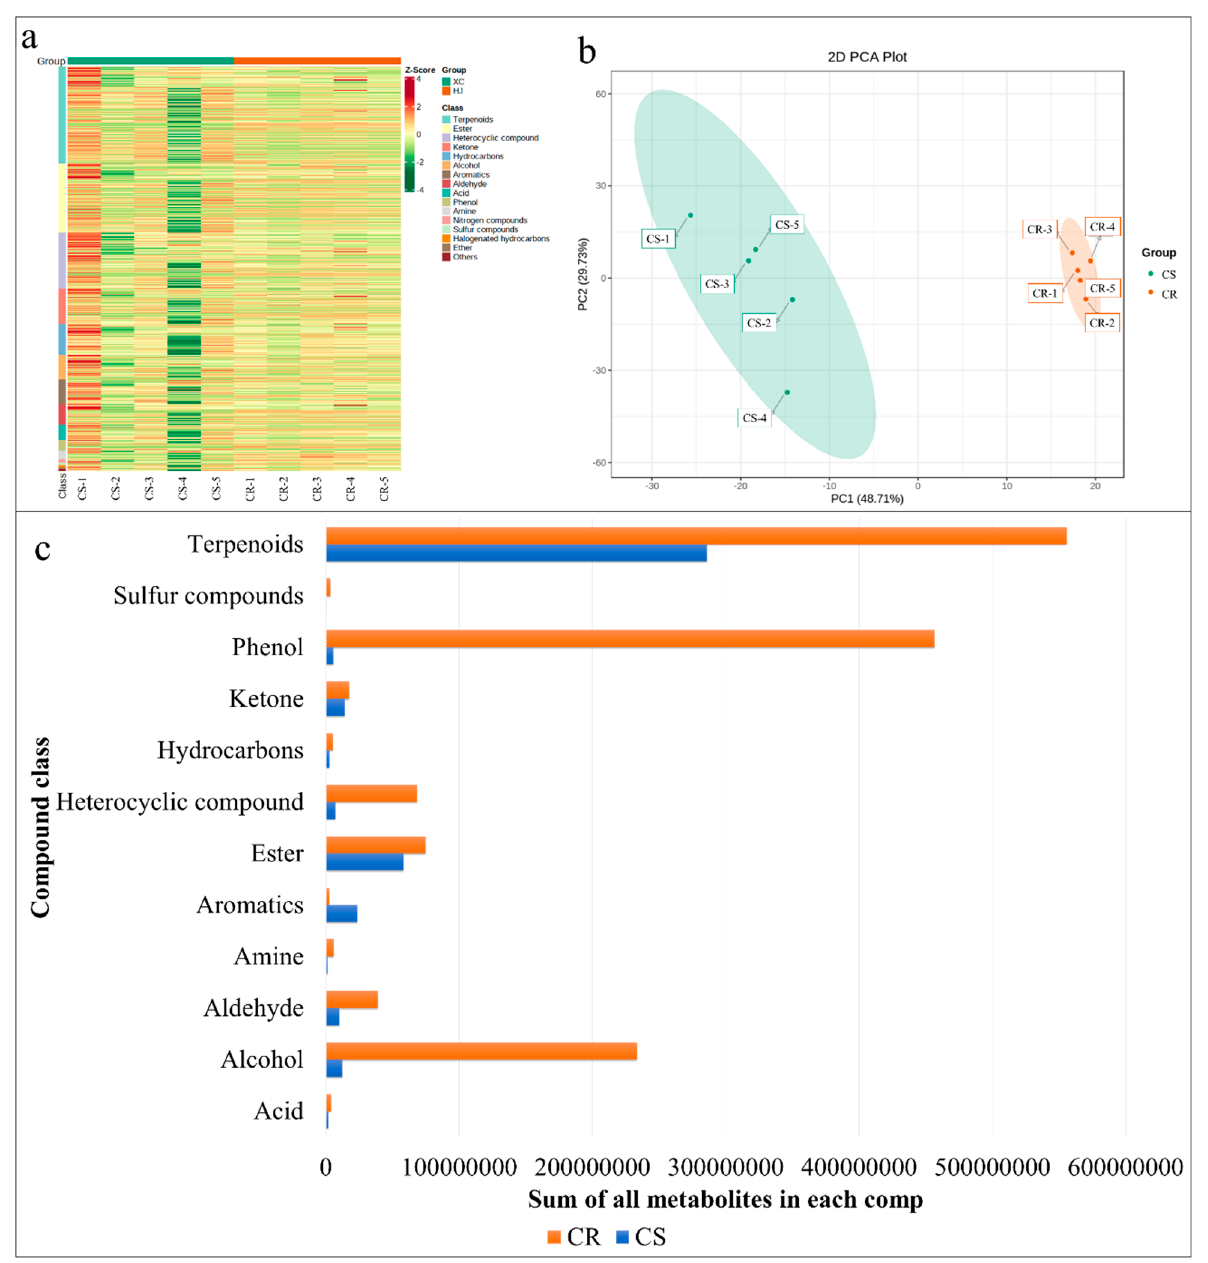
Figure 2. ( a ) Sample population cluster plot. The x -axis represents sample names, the y -axis represents the metabolite information, i.e., fruit type and the metabolite primary classes. ( b ) Grouped PCA plot. ( c ) Comparison of different compound classes accumulated in CS and CR. Where CS and CR represent C. x sinensis and C. reticulata , respectively.